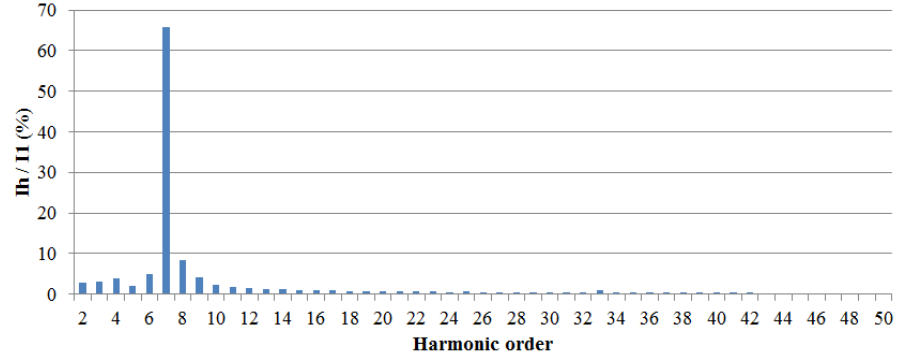
Figure 17. Current harmonic components at the point of common coupling (PCC) when the system is unstable owing to short line